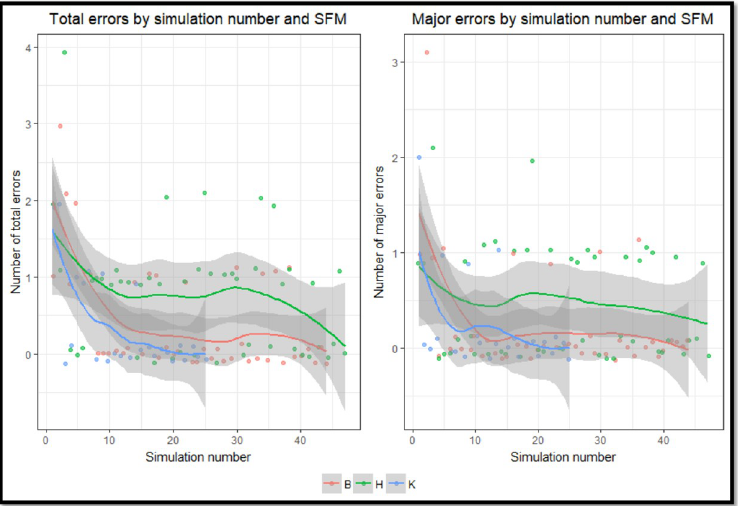
Fig 2. Number of errors in sequential simulations performed by each of the three standardized family members (SFM). The SFM are represented by their first initials B, H, and K. Points are jittered to improve visualization. Trend for each SFM is shown using loess smoothing with 95% confidence